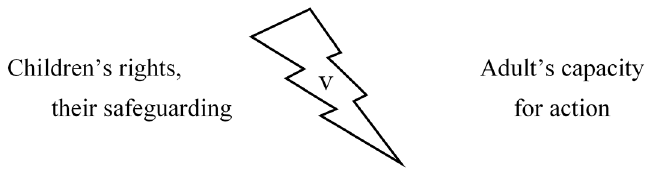
Figure 2. Possible germ cell around the implementation of children’s rights and